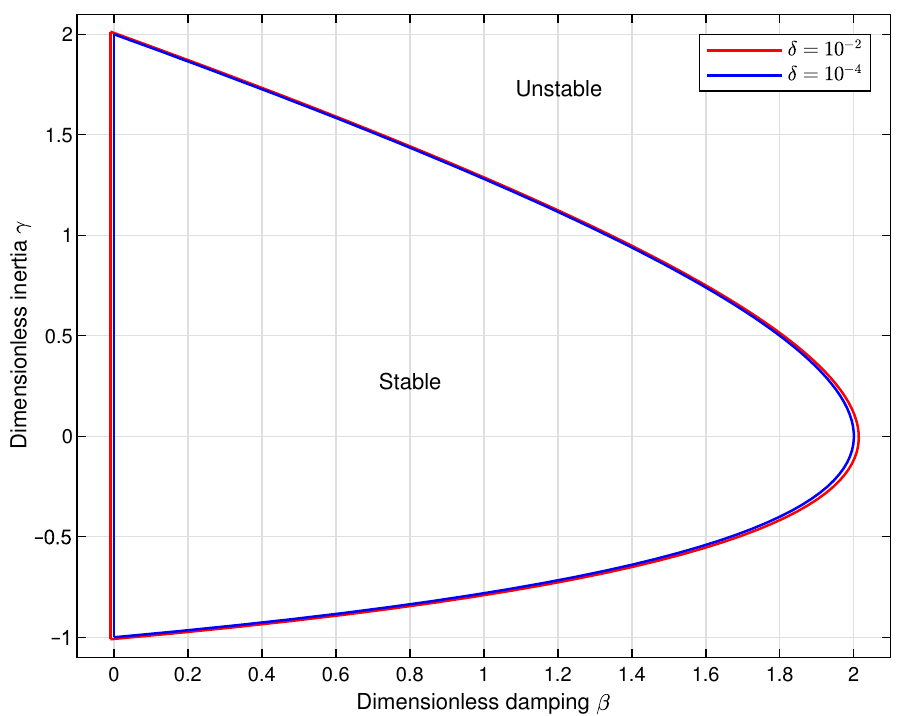
Figure 3. Stability boundaries for virtual mass-damper